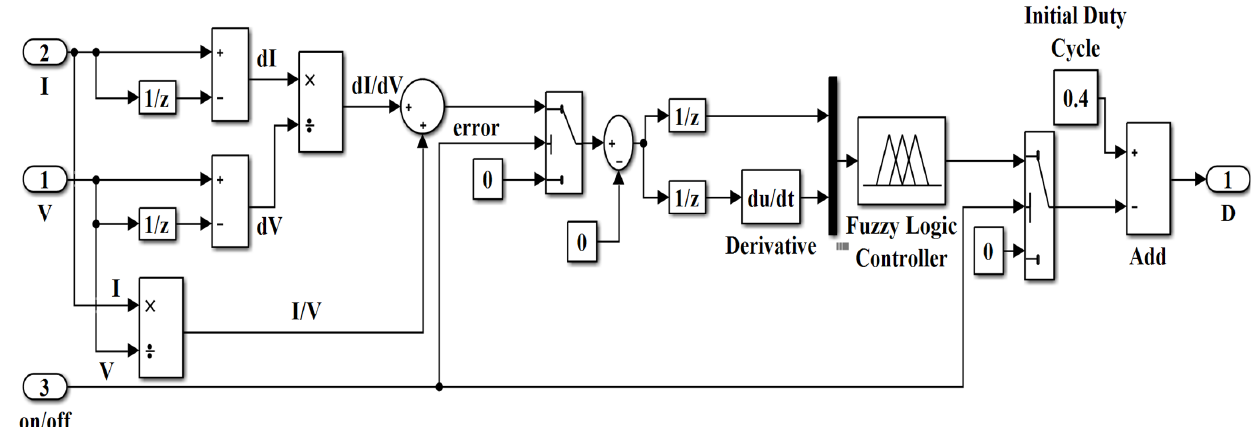
Figure 14. Sub-System for F-LC MPPT.